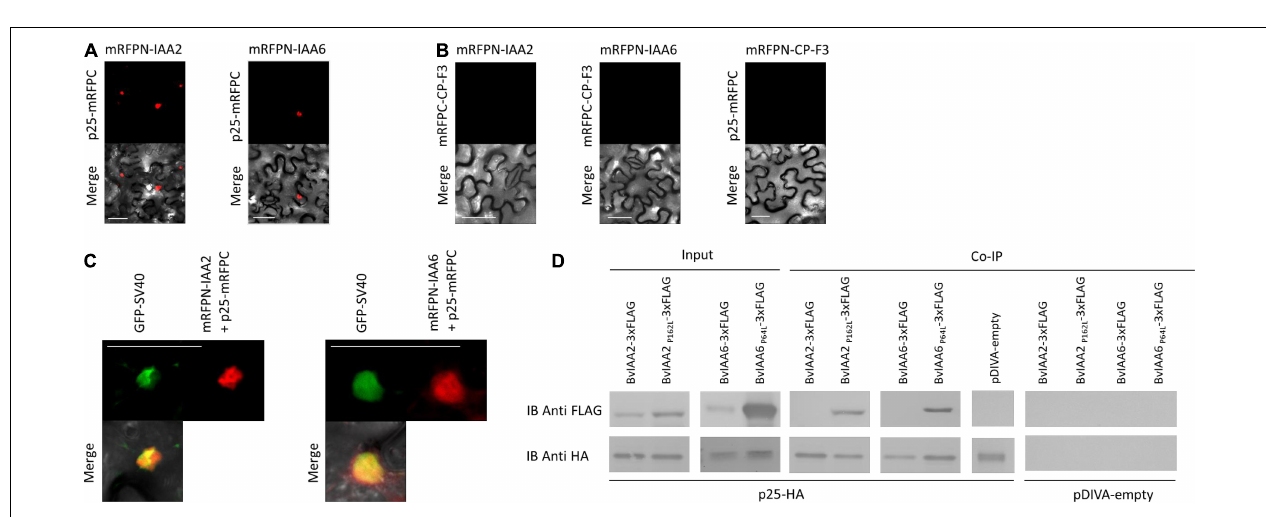
FIGURE 3 | Confirmation of the BNYVV p25 interaction with IAA2 and IAA6 by bimolecular fluorescence complementation and co-immunoprecipitation. The candidates were co-expressed in N. benthamiana leaves by A. tumefaciens C58C1 cells harboring (A) pCB:p25-mRFPC/pBiFC-mRFPN-IAA2 or pCB:p25-mRFPC/pCB:mRFPN-IAA6 to test the interaction and (B) pCB:mRFPC-CP-F3/pCB:mRFPN-IAA2, pCB:mRFPC-CP-F3/pCB:mRFPN-IAA2 or pCB:p25-mRFPC/pCB:mRFPN-CP-F3 to test for autoactivation of the fusion proteins. (C) Additionally, the interacting BiFC partners were co-expressed with the nuclear marker pDIVA:GFP-SV40 to confirm the nuclear localization of the interaction. Images were taken at 4 dpi. Scale bars, 50 µ m. (D) Immunoblot (IB) showing the Aux/IAA proteins coimmunoprecipitated with p25. The total proteins were isolated from Agrobacterium -infiltrated N. benthamiana leaves expressing